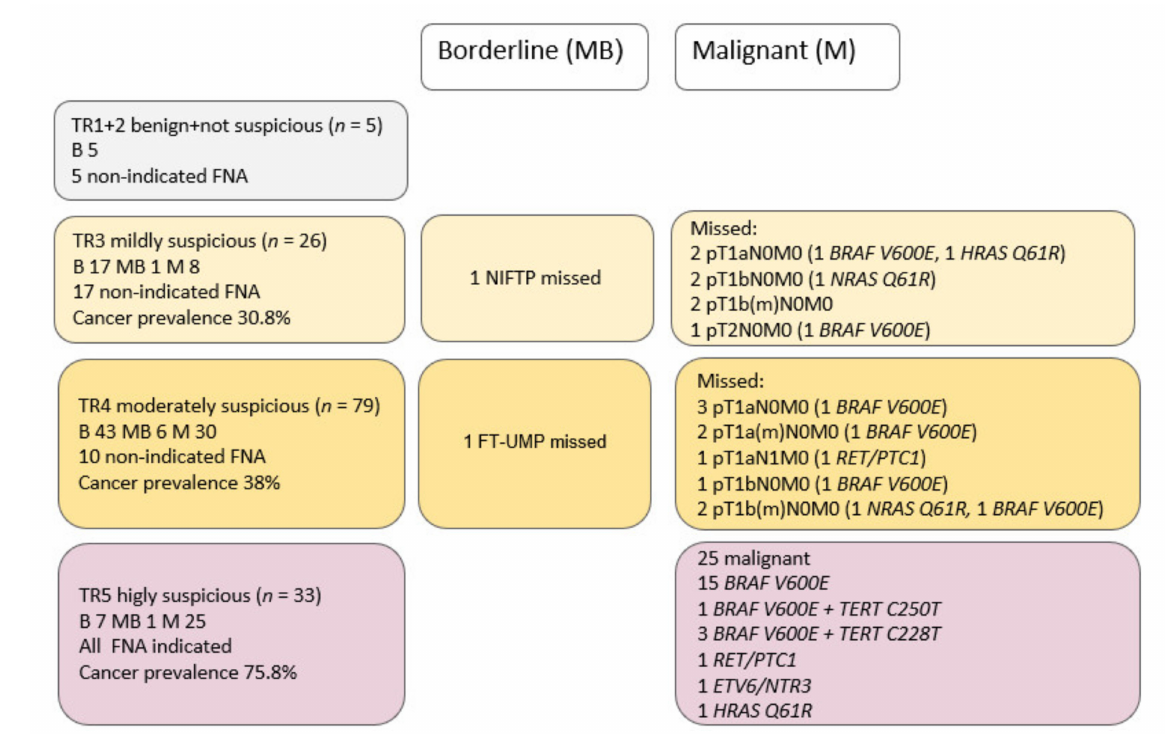
Figure 2. Risk stratification of thyroid nodules on ultrasound using the American College of Ra- diology Thyroid Imaging Reporting and Database System (ACR TI-RADS; TR) and staging (TNM 8th edition) of “missed” papillary thyroid carcinomas in TR3/TR4 groups if FNA indication would be strictly followed according to thyroid nodule size. Molecular genetic results are mentioned according to the ultrasound group TR1–TR5. Cancer prevalence was calculated as the number of people with TC in each group of patients according to ACR TI-RADS (excluding MB). Benign (B),borderline (MB), and malignant (M) cohorts of patients were determined by histology. NIFTP—non-invasive follicu- lar thyroid neoplasm with papillary-like nuclear features; FT-UMP—follicular tumor of uncertain malignant